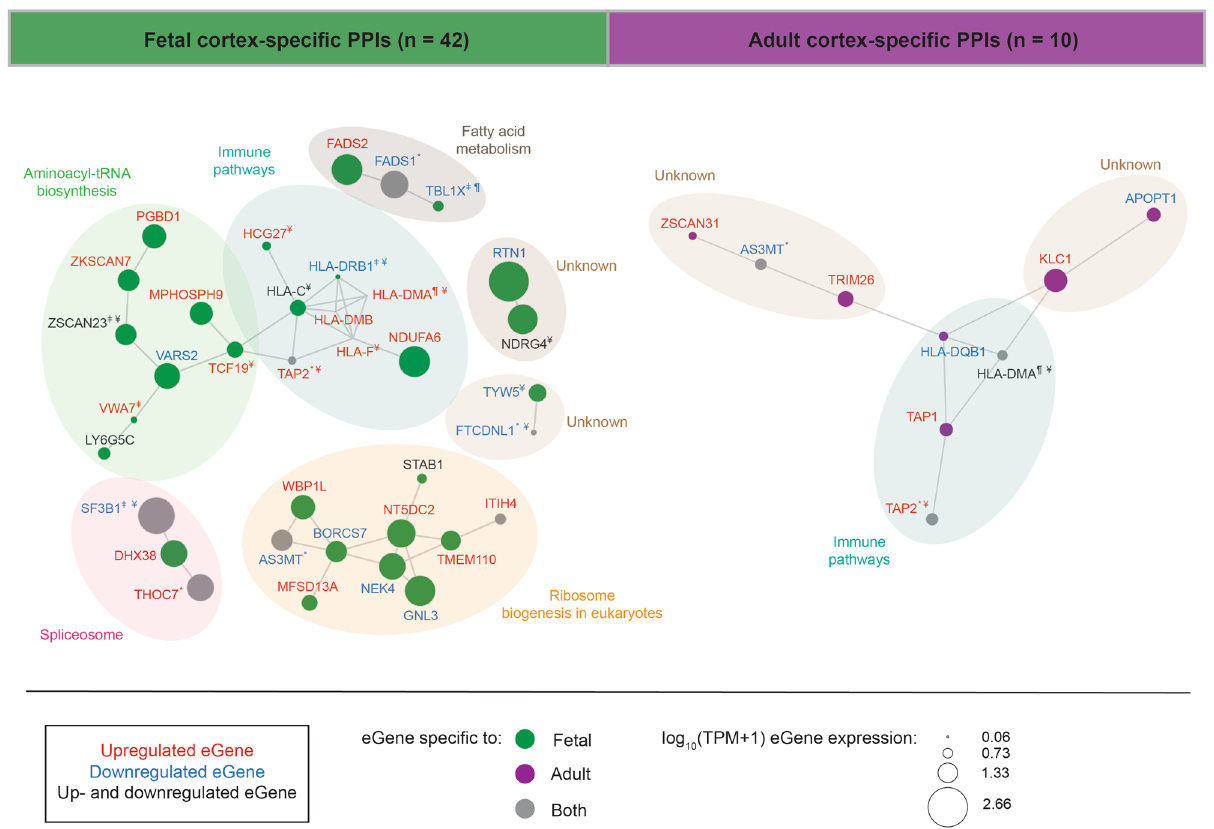
Figure 4. Fetal and adult cortical tissue-specific PPI networks with immune and growth related phenotypes are affected by ASD-associated eQTLs. We identified 42 PPIs in the fetal and 10 PPIs in the adult cortical tissues. Louvain clustering identified seven PPI modules within the fetal cortex that were enriched for immune pathways, fatty acid metabolism, aminoacyl-tRNA biosynthesis, spliceosome, ribosome biogenesis in eukaryotes and two unknown modules. Adult PPIs form three modules that were enriched in immune pathways and two unknown modules. *Gene transcript levels are associated with the same eQTL in both the fetal and adult cortical tissues. ǂ Genes that have been curated as being involved in ASD (AutDB 31 ; http:// autism. minds pec. org/ autdb/ Welco me. do, assessed on 16/11/2020). ¶ Genes whose transcript levels are associated with a